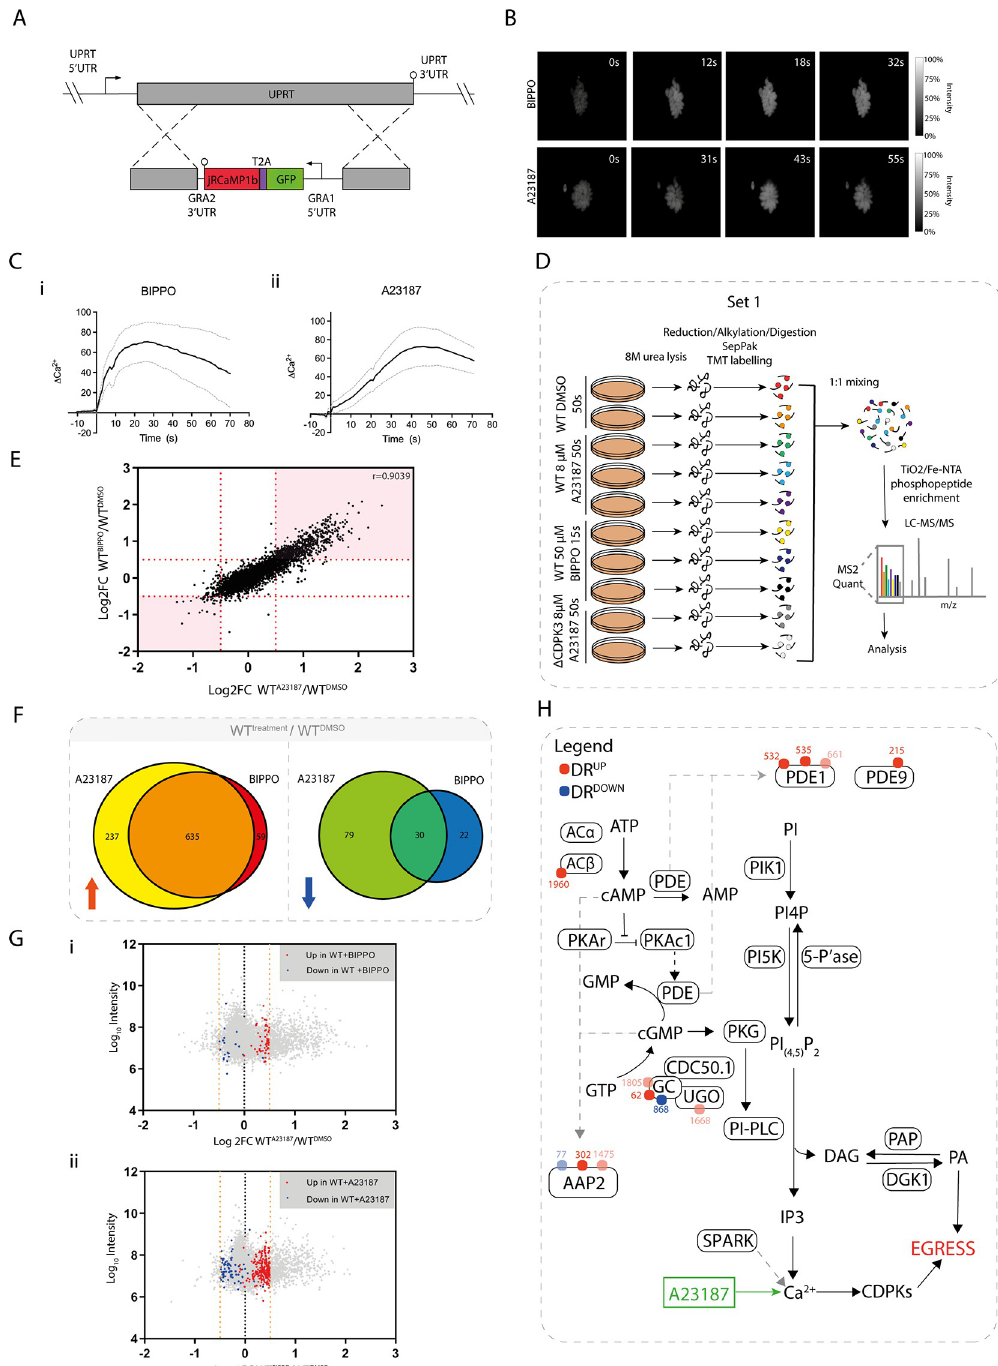
Fig 1. Comparative phosphoproteomics of BIPPO- vs A23187-induced GFP-T2A-jRCaMP1b (WT) parasites at peak cytosolic calcium levels (A) Generation of the calcium sensor line GFP-T2A-jRCaMP1b by integration into the UPRT locus. (B) Video microscopy of intracellular GFP-T2A-jRCaMP1b parasites (red channel) depicted in grey scale, following addition of 50 μ M BIPPO or 8 μ M A23187 at 0s. (C) Ratiometric tracking of mean Ca 2+ response (jRCaMP1b/GFP normalised to 0), following addition of (i) 50 μ M BIPPO or (ii) 8 μ M A23187. Grey dotted lines represent ± SEM. Data was collected from � 10 vacuoles (in separate wells) over � 6 days. (D) Schematic summary of the TMT-10-plex experiment (set 1) and workflow used to quantify the phosphoproteomes of intracellular WT tachyzoites treated with 50 μ M BIPPO (15s) or 8 μ M A23187 (50s). Δ CDPK3 parasites treated with 8 μ M A23187 (50s) were included to facilitate later analyses. (E) Correlation of